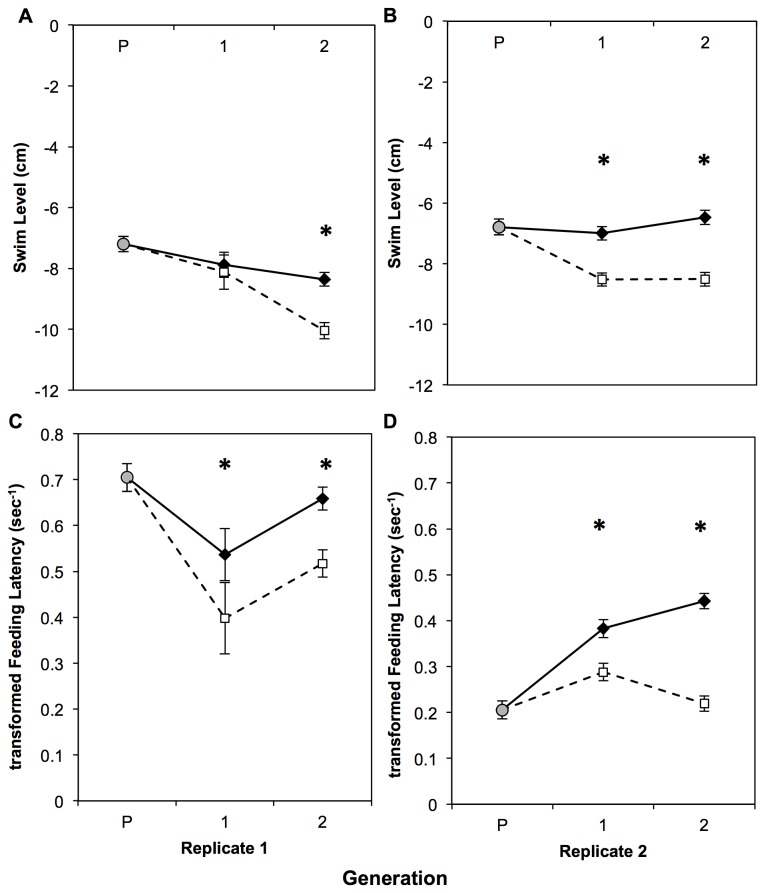
Response of Swim Level and Feeding Latency to selection on horizontal position in zebrafish.Replicate 1 (A & C), Replicate 2 (B & D). P = unselected parental generation (gray circle), 1 = first generation progeny from selected parents, 2 = second generation progeny from selected parents. Black diamonds with a solid line represent means ± SE of High line fish, open squares with a dashed line represent means ± SE of Low line fish. “*” indicate significant (p<0.05) differences between lines within a generation using a mixed-model ANOVA.